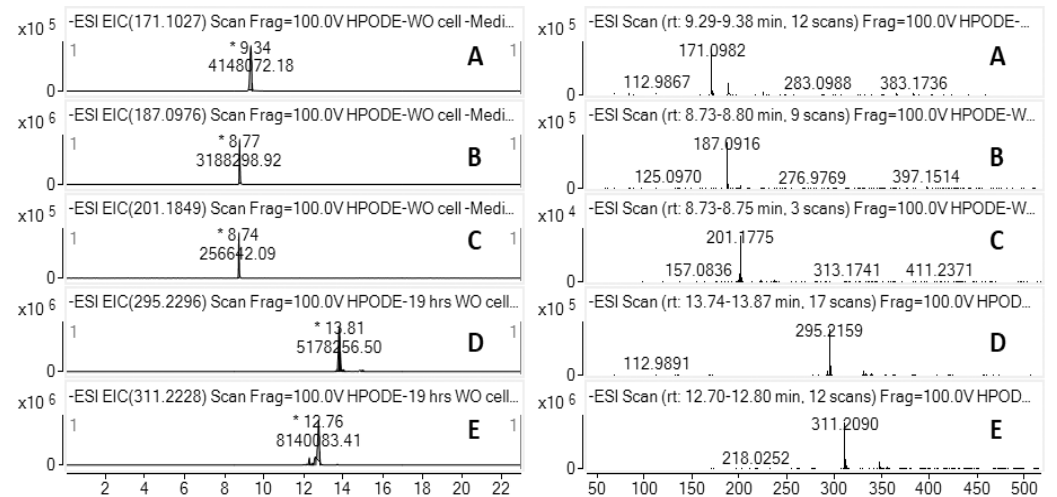
Figure 2. Representative TLC radioautograph of 14 C-13-HPODE and decomposition products from fully differentiated Caco-2 cells and media: ( A ) cell media lipid extract; ( B ) intracellular lipid extracts. Dashed red line indicates 13-HODE fraction.